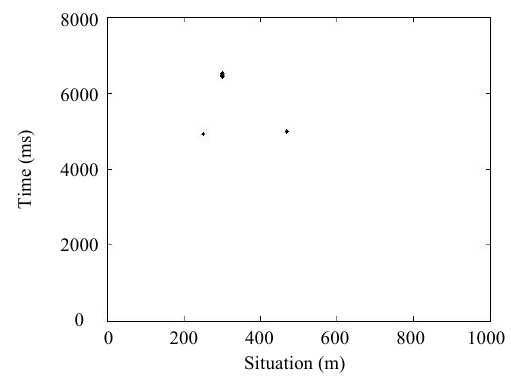
Fig. 10 Detection result of proposed method.